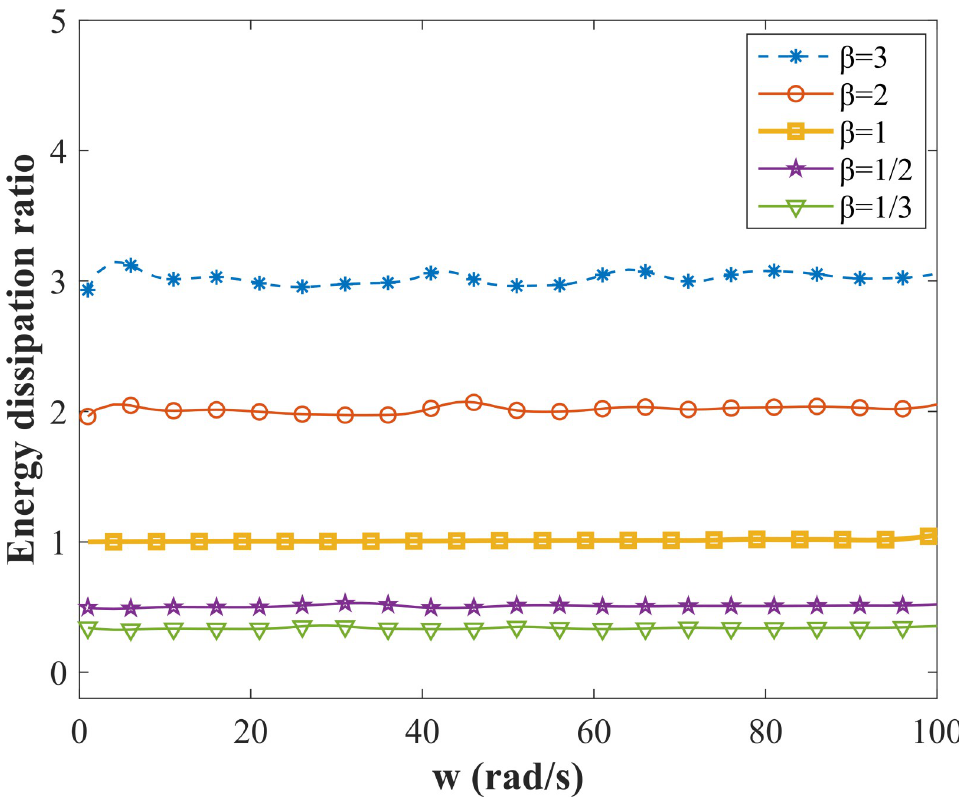
Fig 8. Ratio of energy consumption in extension travel and compression travel.